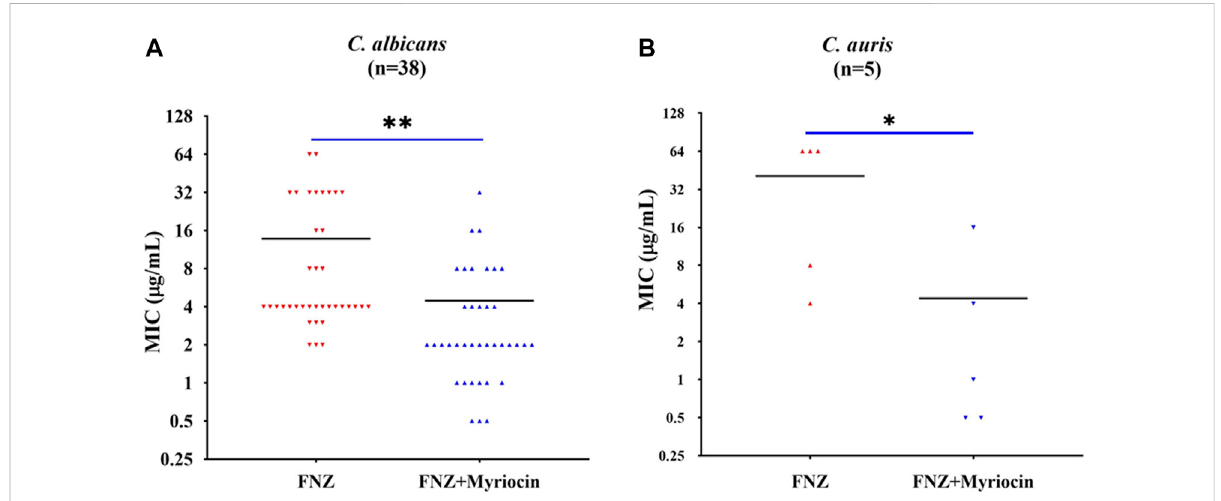
Myriocin can signi fi cantly reduce theMIC values of FLC against (A) C.albicans isolates ( n = 38) (** p = 0.0017, theFNZ (10 μ g/ml) + myriocin(0.5 μ g/ml) treated group compared to the FNZ (10 μ g/ml) group, t-Test) and (B) C. auris isolates ( n = 5) (* p = 0.036, the FNZ (10 μ g/ml) + myriocin (0.5